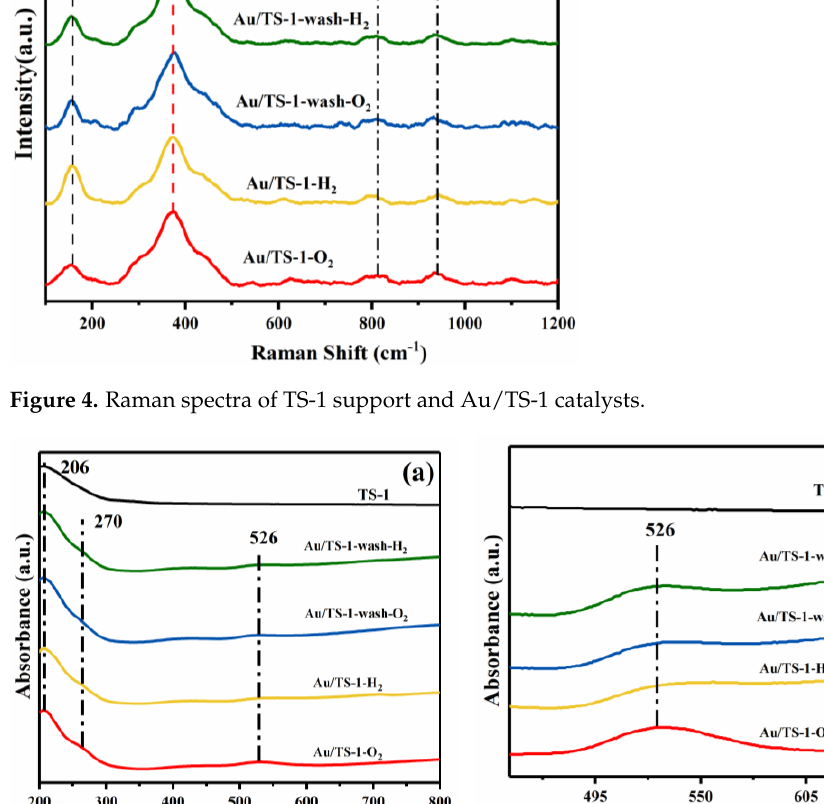
Figure 4. Raman spectra of TS-1 support and Au/TS-1 catalysts.